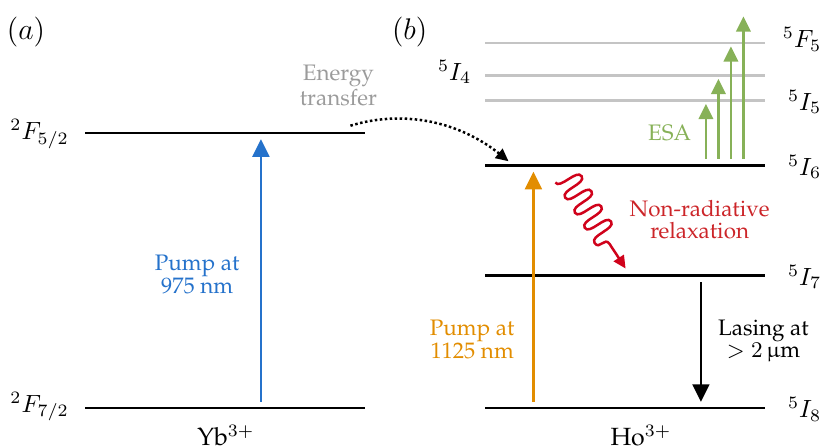
Figure 1. Simplified diagram of the energy levels of ( a ) Yb 3 + and ( b ) Ho 3 + ions, as well as the processes involved to generate lasing beyond 2 µ m with pump signals at 975 and 1125 nm.